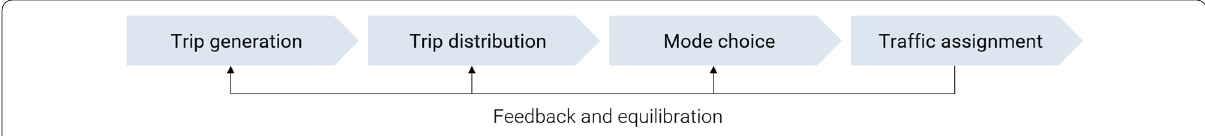
Fig. 2 Classical four steps of macroscopic transport